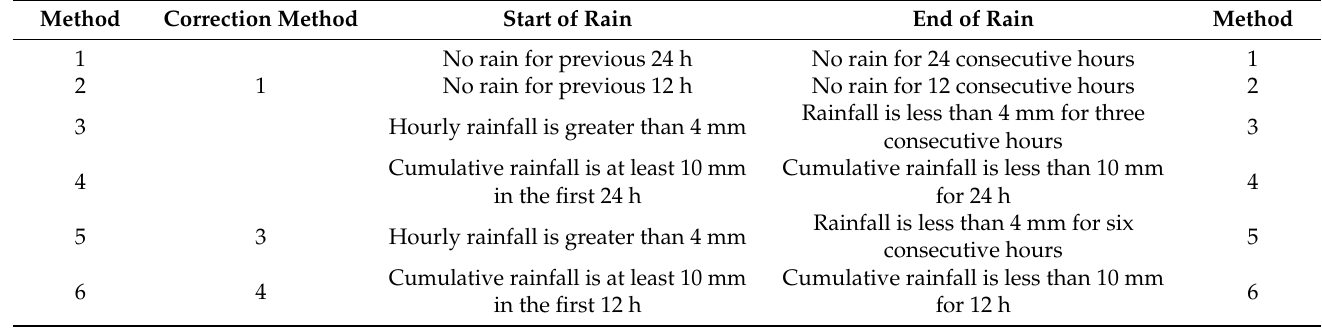
Table 5. Six rainfield-cutting